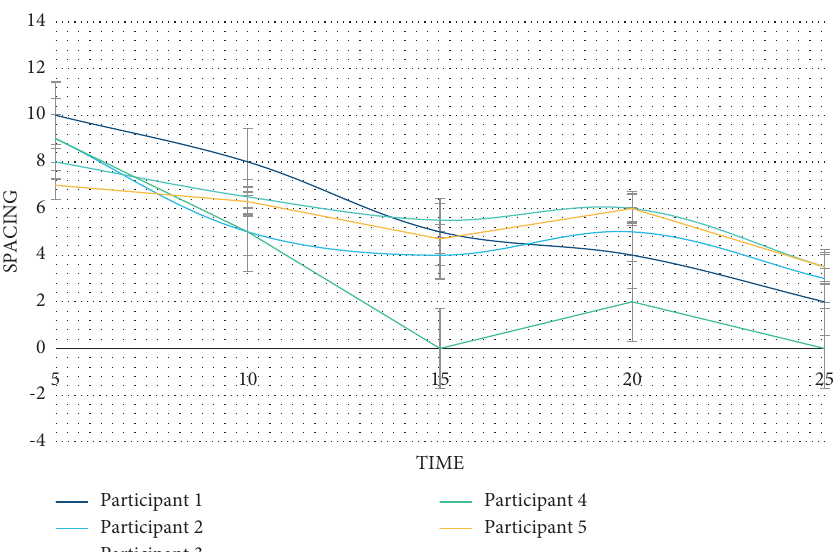
Figure 14: Statistics of eyelid closure data of five